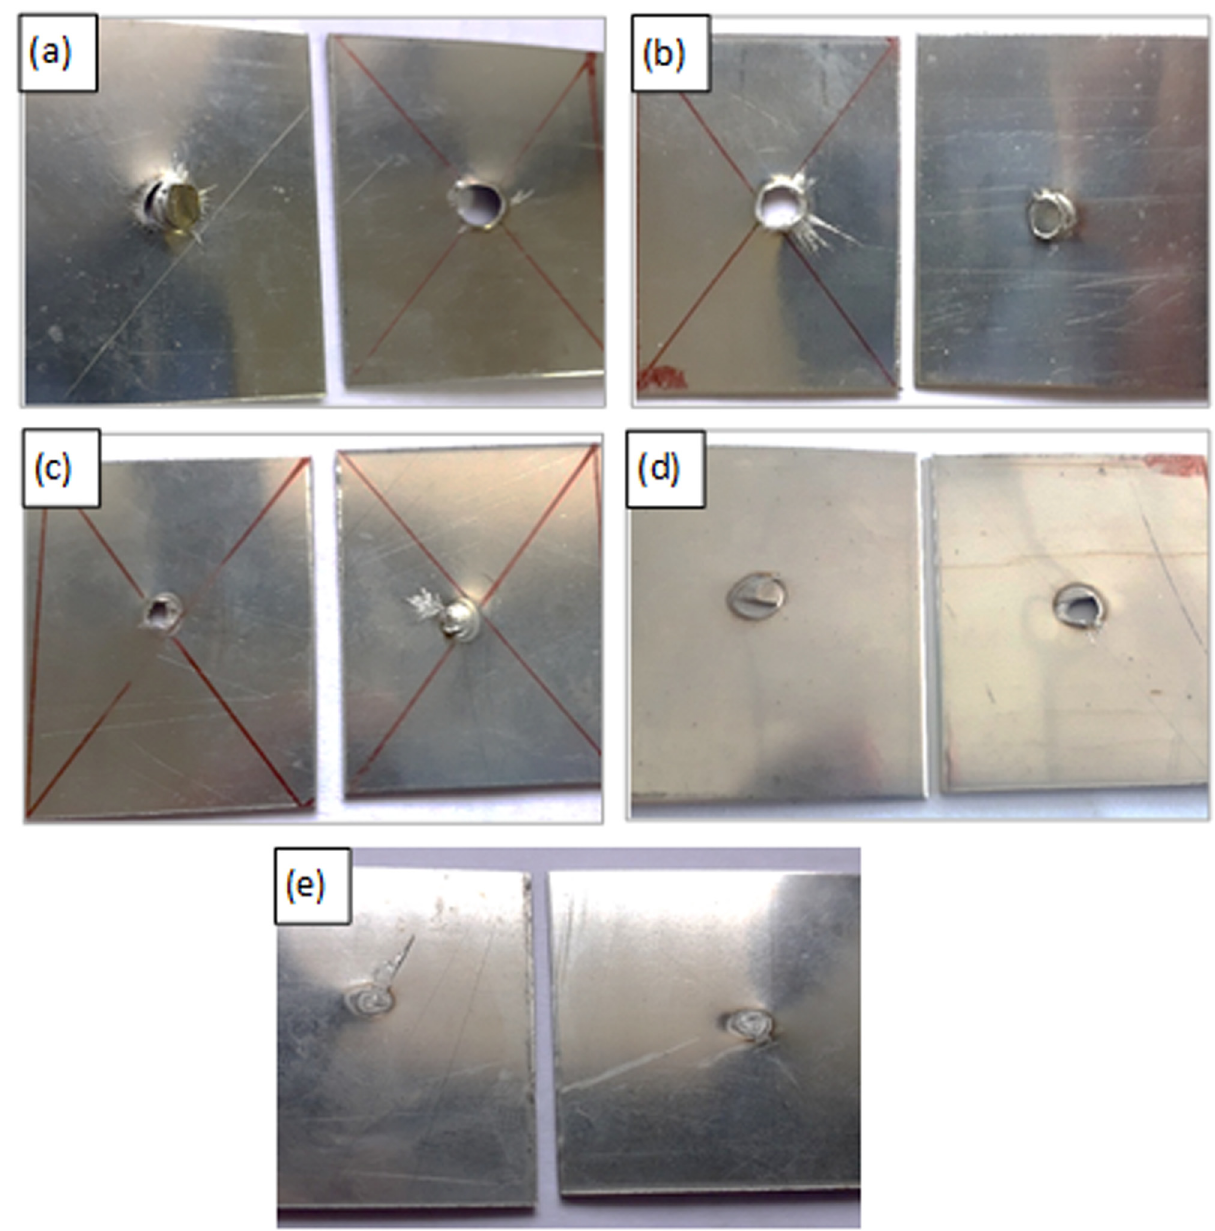
Figure 10: Various failure modes observed: ( a ) double PF mode, ( b ) PF mode, ( c ) partial thickness with PF, ( d ) interfacial fracture with PF and ( e ) IF